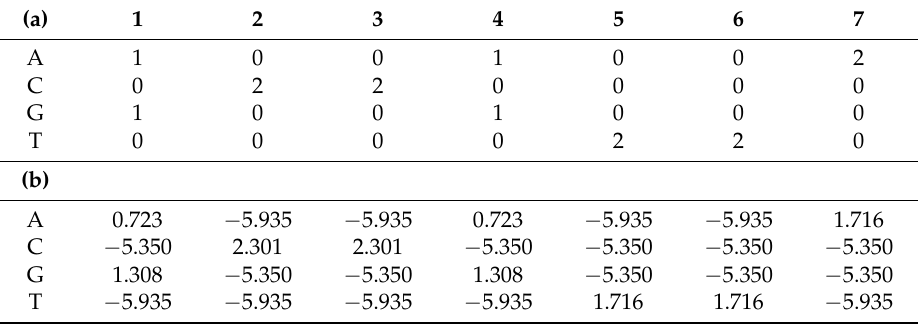
Table 3. Updating the node in Table 2 (a) by the new input sequence “GCCATTA” and the